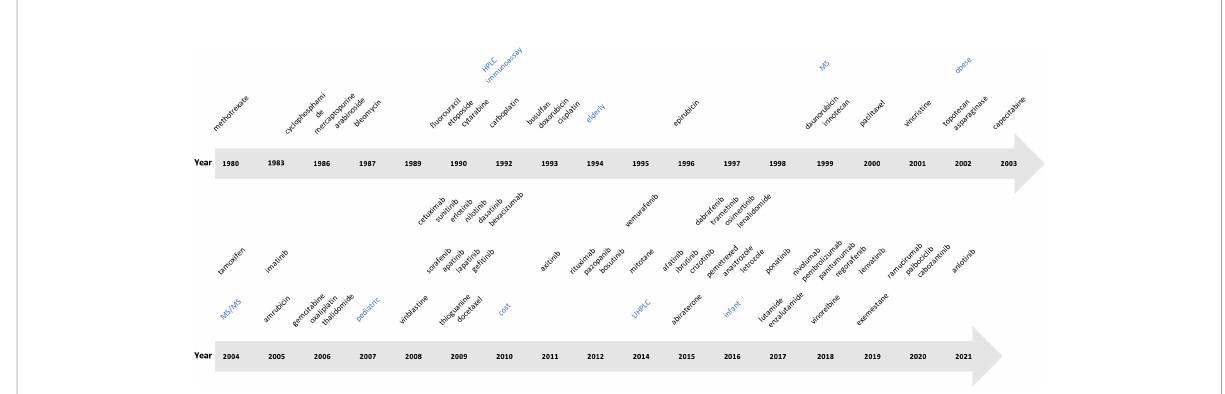
FIGURE 3 Timeline of the year of fi rst report identi fi ed for individual antineoplastic agents and selected concept terms (blue). HPLC: high-performance liquid chromatography; MS: mass spectrometry; MS/MS: tandem mass spectrometry; UHPLC: ultra-high-performance liquid